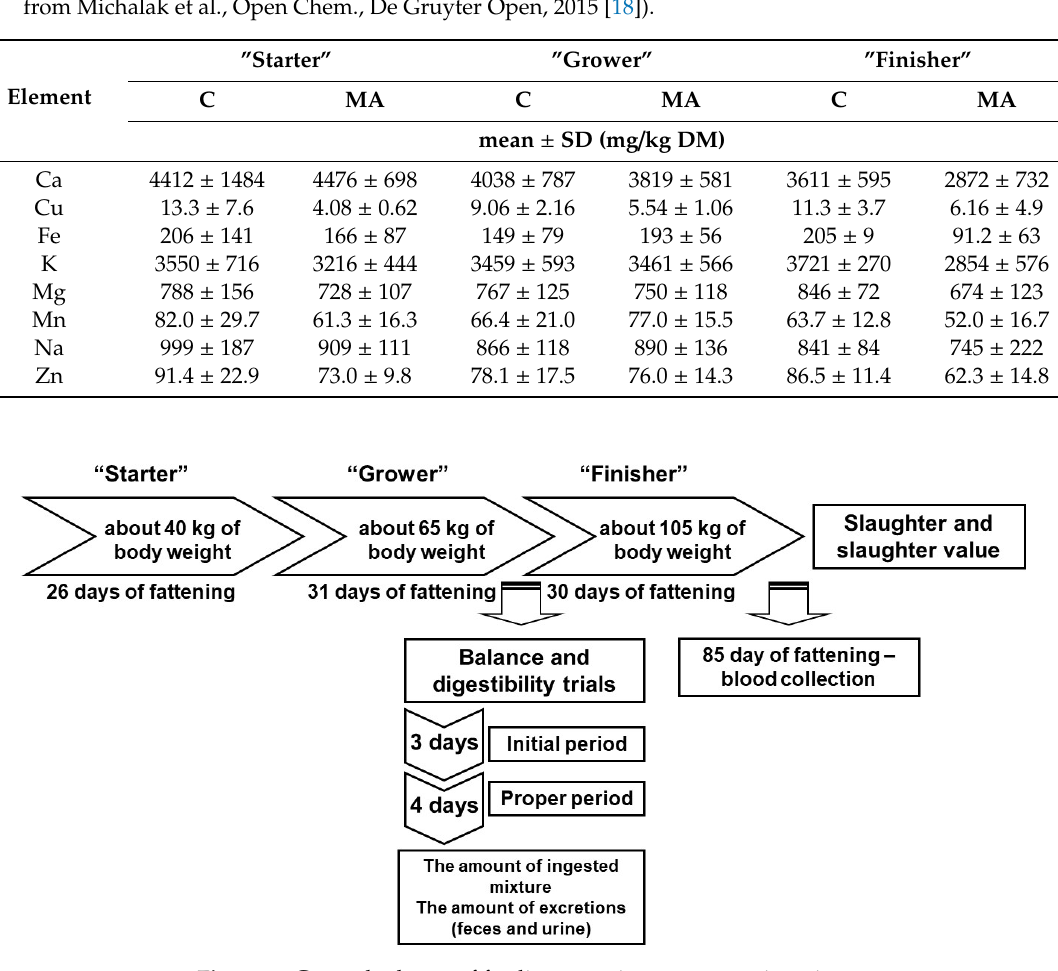
Table 3. The mineral composition of the feed for pigs in the control and experimental groups (Data